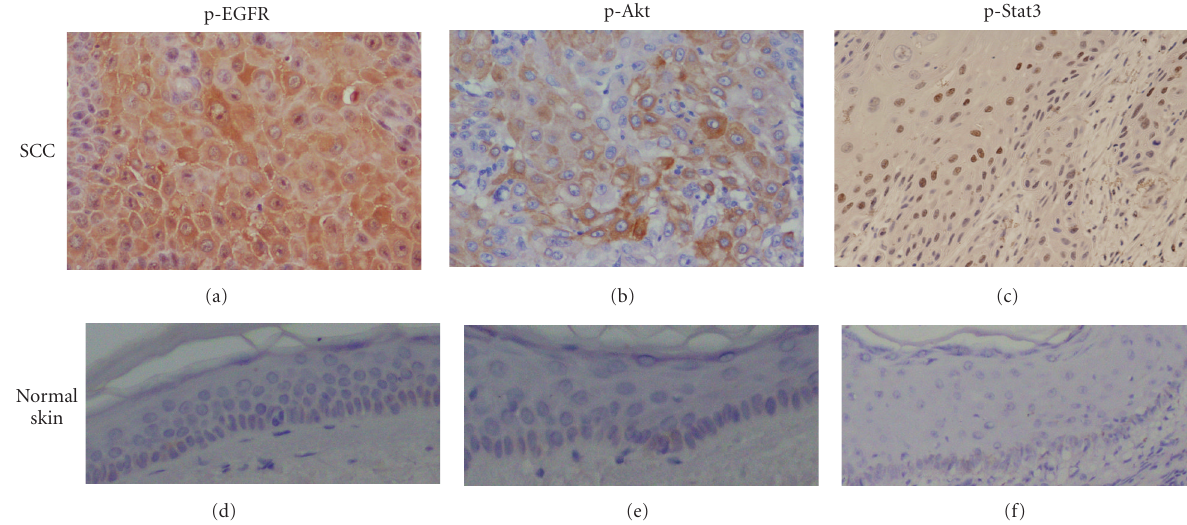
Figure 1: Over-expression of p-EGFR, p-Akt, and p-Stat3 in human cutaneous SCC tissues. Para ffi n-embedded serial sections of SCC from the same patient were examined immunohistochemically for p-EGFR, p-Akt, and p-Stat3 (tyr705) expression. Characteristic immunostaining of p-EGFR, p-Akt and p-Stat3; original magnification: × 200. P-EGFR (a) and p-Akt (b) protein were overexpressed mainly in the cytoplasm and partially in the nucleus. P-Stat3 (tyr705) protein was detected in the nuclei (c). None of p-EGFR p-Akt or p-Stat3 protein were seen in normal skin ((d), (e), (f)); original magnification: × 100.